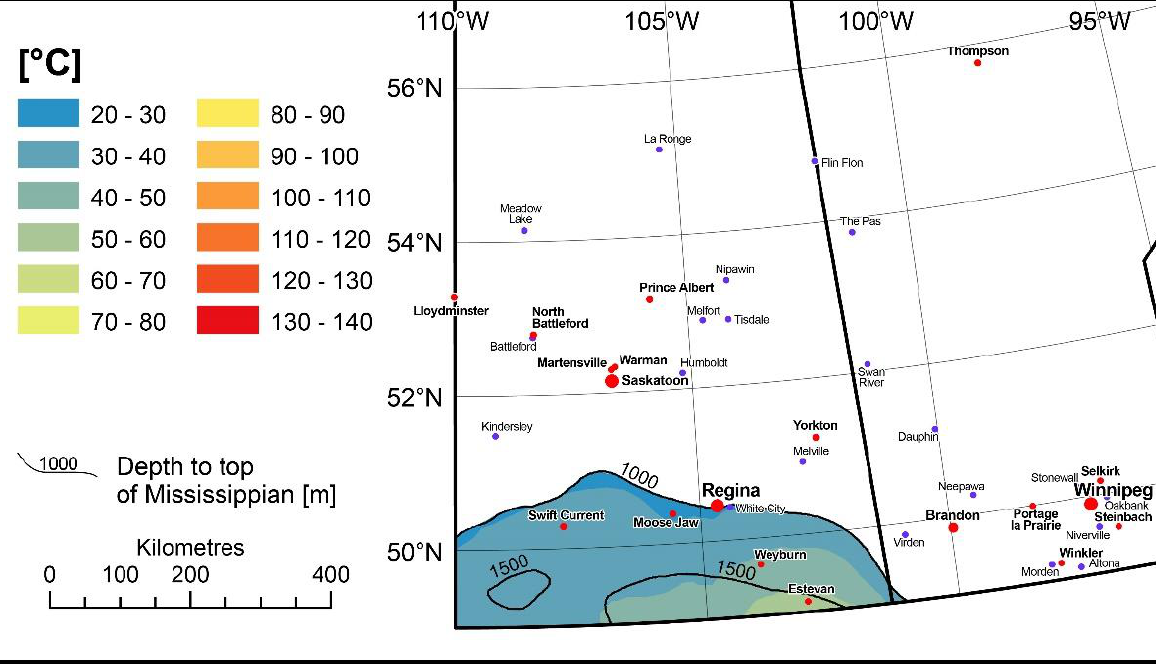
Figure A5. Temperatures top of Mississippian—Saskatchewan – Manitoba WCSB.